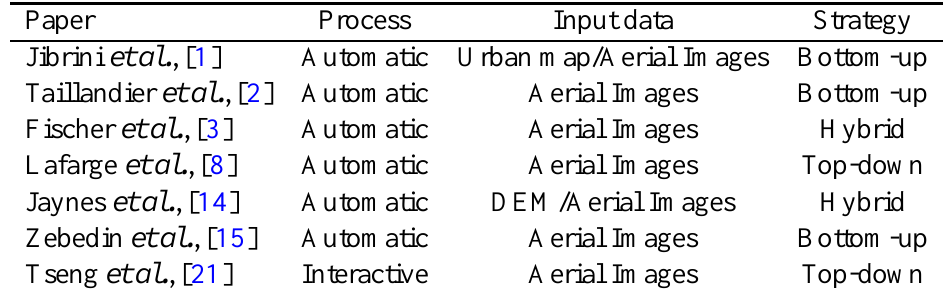
Table 1. Some feature-based approaches developed for 3D polyhedral building modeling from aerial